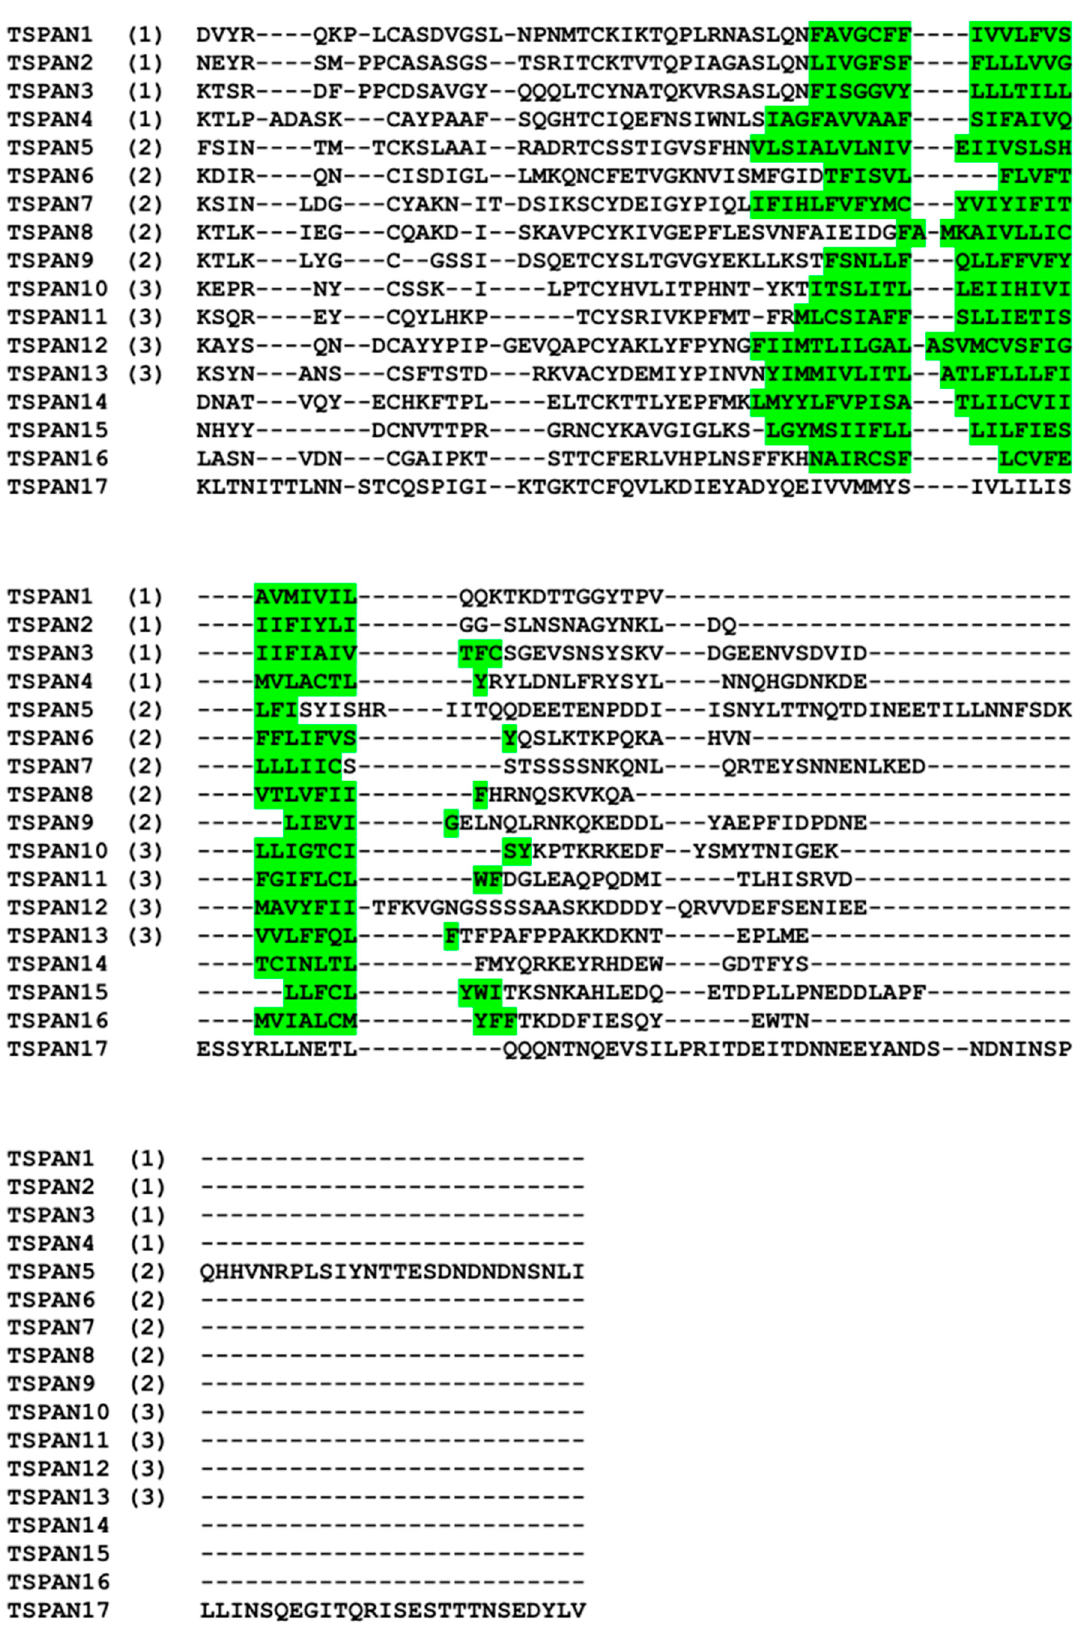
Figure 2. Multiple sequence alignment of 17 tetraspanins in E. histolytica . Putative membrane-spanning regions provided by UniProt are in green. The CCG motifs are highlighted in yellow. Locations of EC1 and EC2 are displayed respectively. Numbers in parentheses indicate subgroup